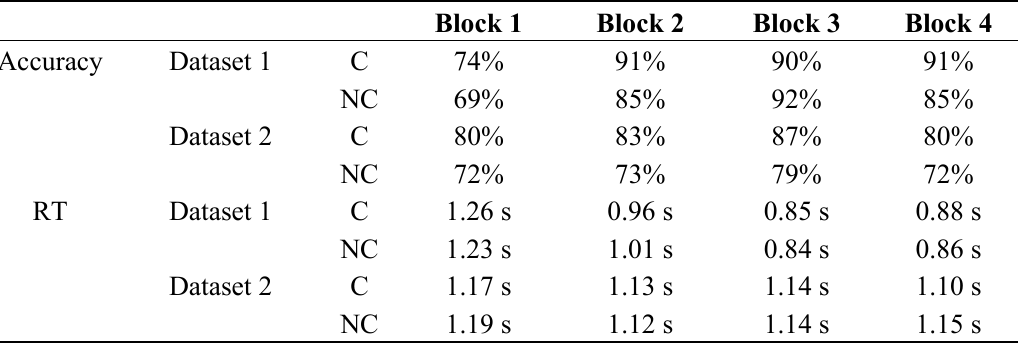
Table 3. Average accuracy and reaction-time for competition (C) and non-competition (NC) trials in Dataset 1 and Dataset